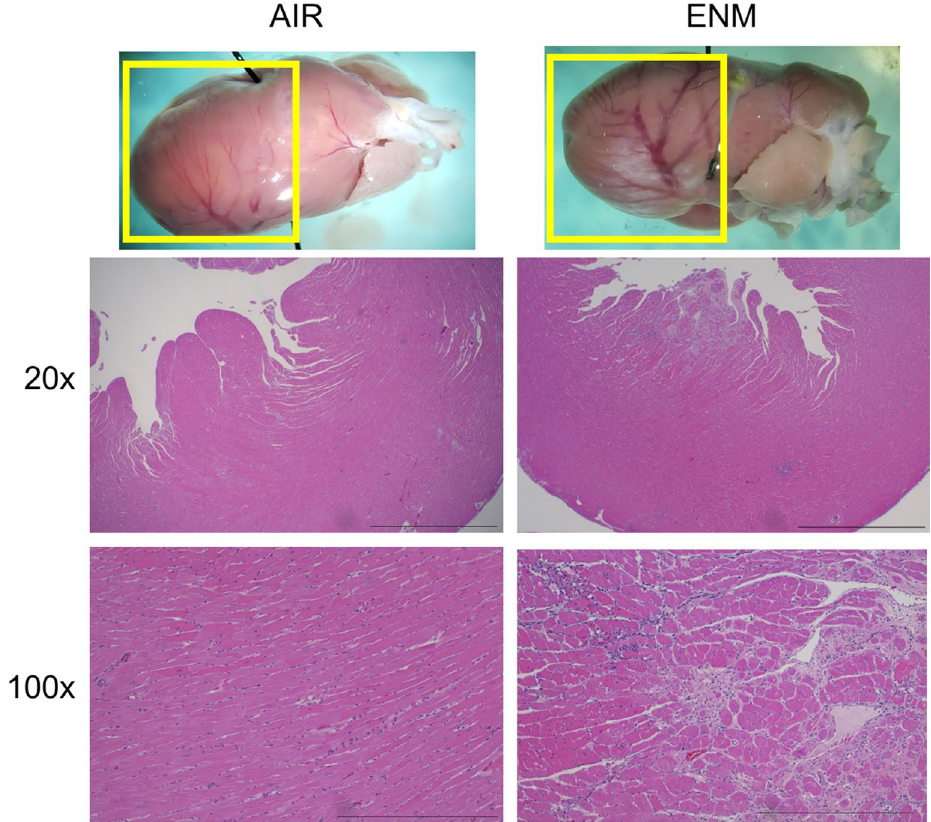
Figure 5. Histological analysis of cardiac tissue at 12 months. Histological analysis of cardiac tissue from offspring of pregnant dams exposed to nano-TiO 2 at 12 months revealed histopathological alterations compared with tissue from the Sham-Control (AIR) group. n = 3. Reference bar at 20× = 2 mm. Reference bar at 100× = 500